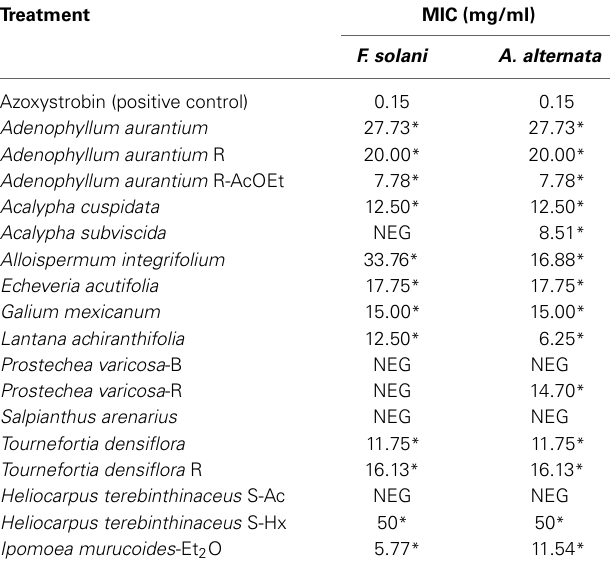
Table 3 | Antifungal activities (MIC) of crude plant extracts of some plants from Oaxaca against F. solani and A.